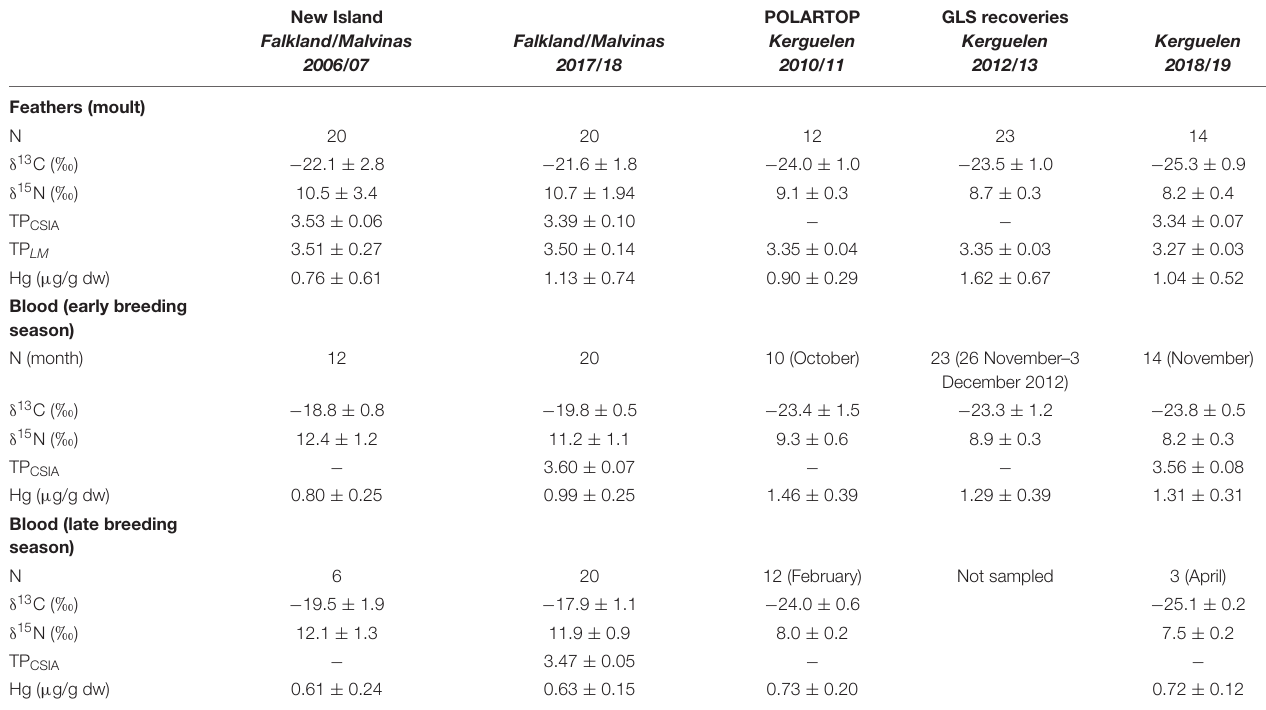
TABLE 2 | Summary of stable isotope and mercury data of Thin-billed Prions (mean ± standard deviation), as well as trophic position (TP) estimates based on linear models (TP LM ) or compound-specific isotope analyses of amino acids (TP CSIA ).